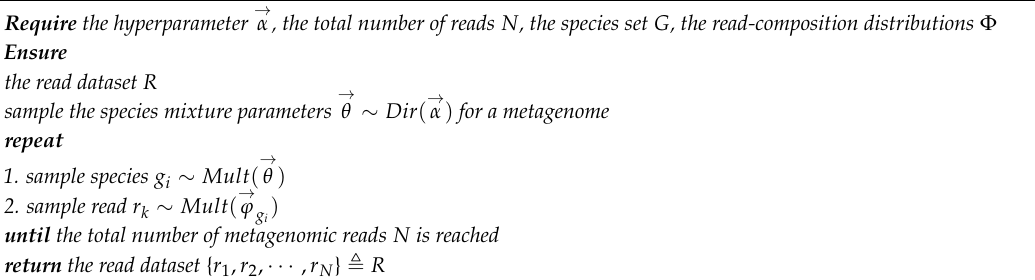
Algorithm 1 (A finite mixture and latent Dirichlet model for